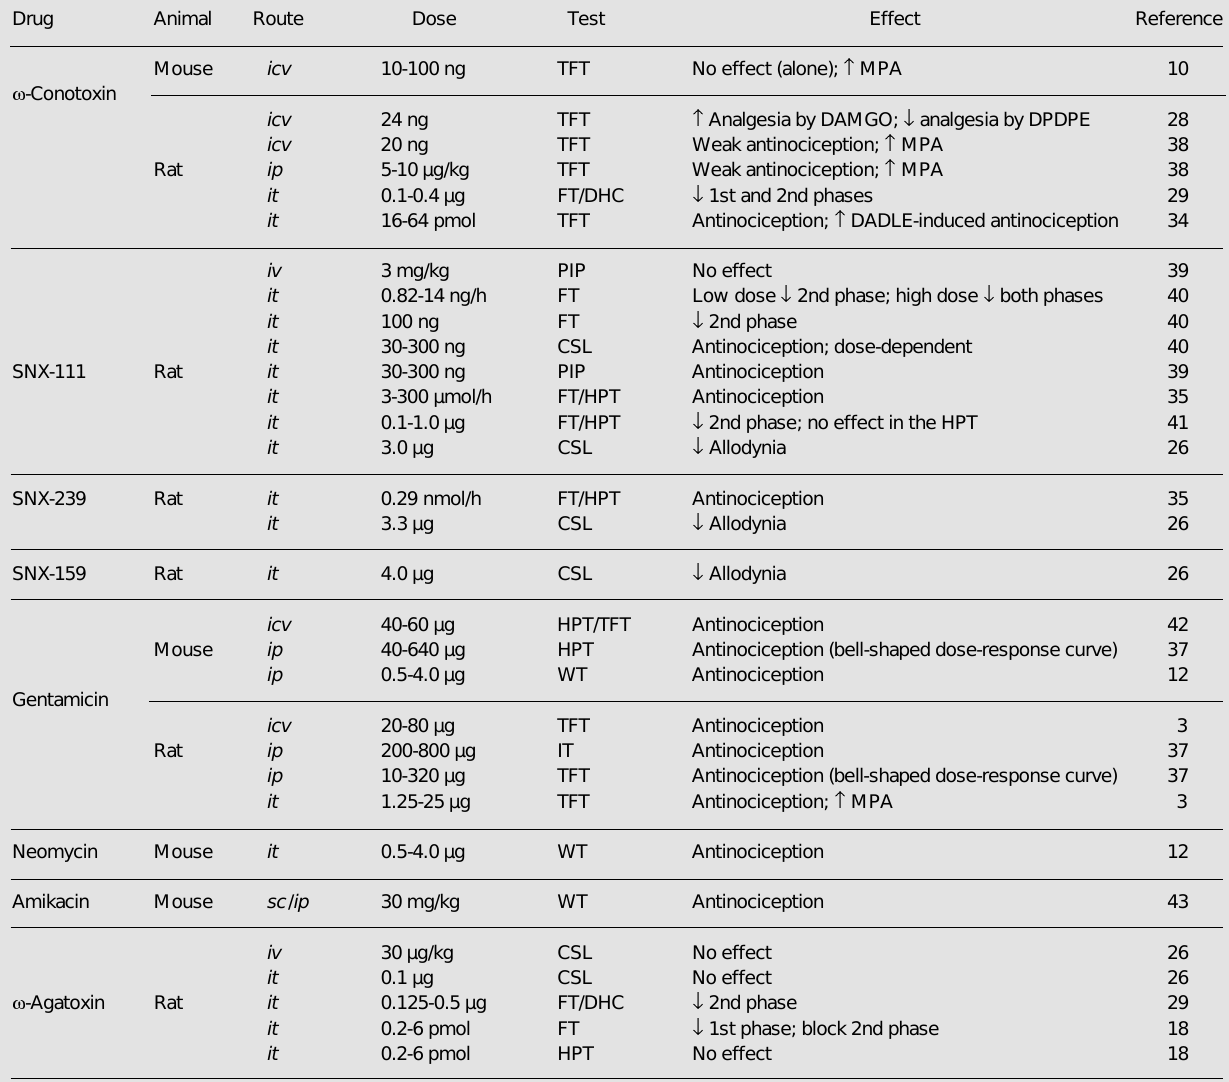
Table 4 - Effects of N- or P-type Ca 2+ -channel antagonists on nociception and opioid-induced antinociception. IT = Incapacitation test; PIP = postincisional pain. For other abbreviations see legends to Tables 2 and 3.